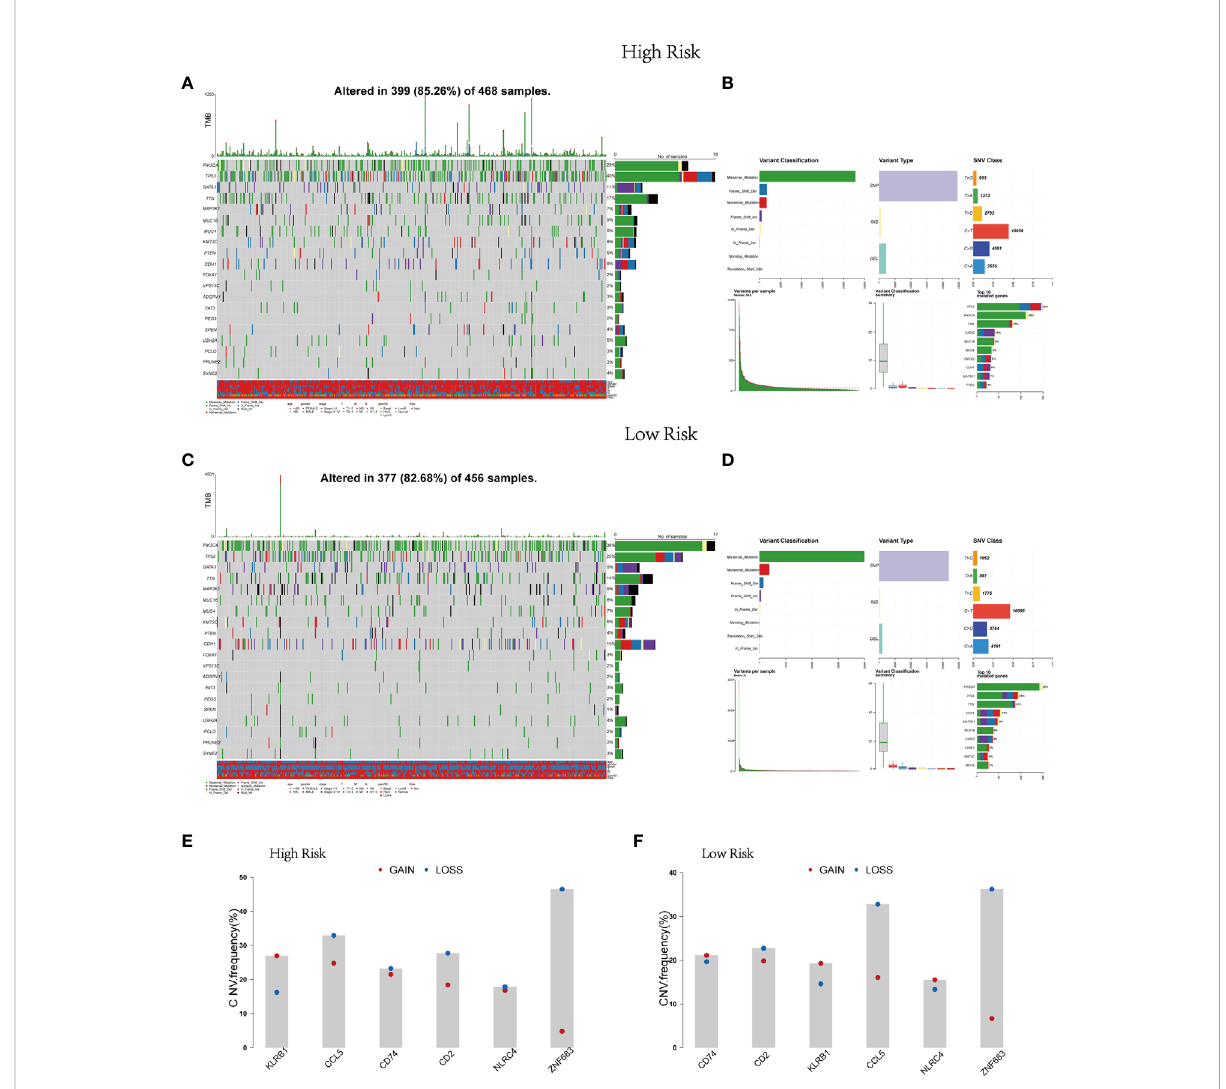
FIGURE 3 Landscape of mutation pro fi les in BRCA samples. Waterfall plots of 20 genes mutation information and bar plots of TMB in high-risk subtype (A) and low-risk subtype (C) . Summary of the mutation information with statistical calculations in high-risk subtype (B) and low-risk subtype (D) . (E, F) The difference of CNV for six Pyro-GPS in high- and low-risk subtypes. BRCA, breast cancer; TMB, tumor mutational burden; CNV, copy number variation; Pyro-GPS, pyroptosis-related genes prognostic